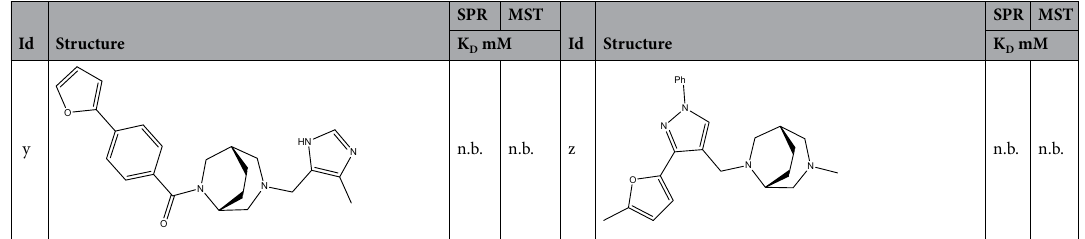
Table 1. Binding affinity of DRP1i27 analogues to human Drp1 isoform 3. n.b is indicative of no calculated binding.